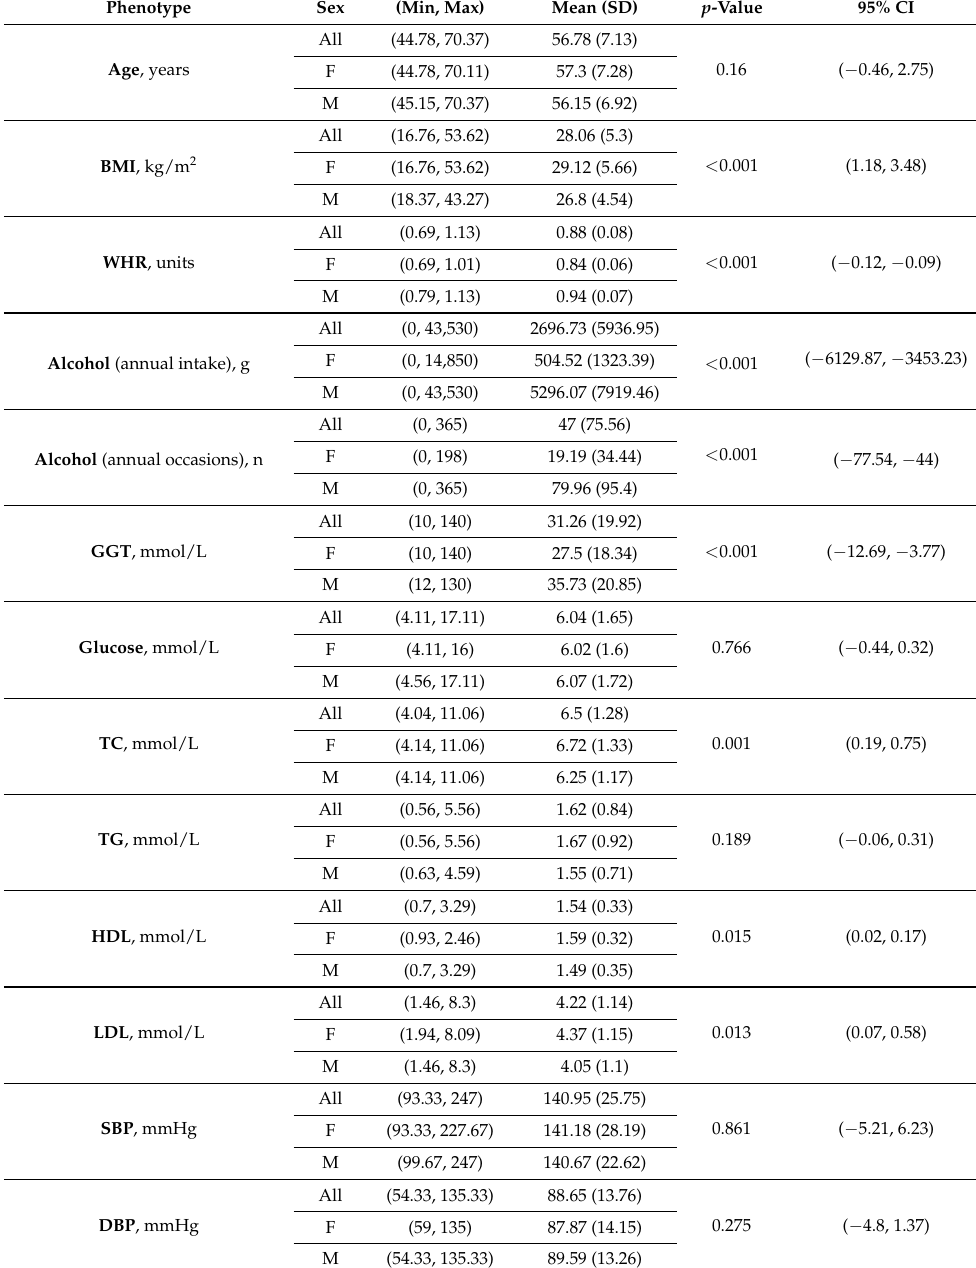
Table A1. Summary of the continuous phenotype data for males and females. Sample size is n = 306, 166/140 female/male. Glucose measurements are only available for n = 298, 159/139 female/male samples. p -values obtained from the Welch’s t -test, testing difference between male and female groups for each variable ( H 0 : mean value of the variable is the same for male and female